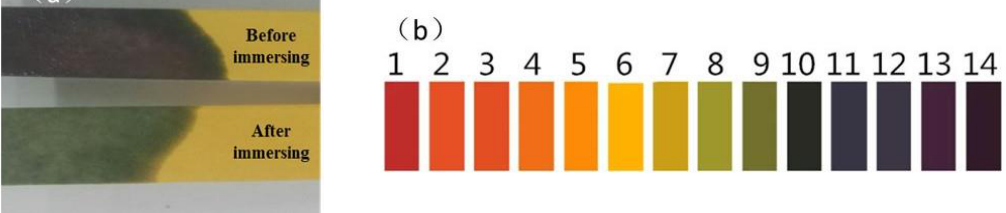
Figure 4. ( a ) The pH value change of alkaline solution. ( b ) The pH paper color swatches after 7 days immersing asphalt.